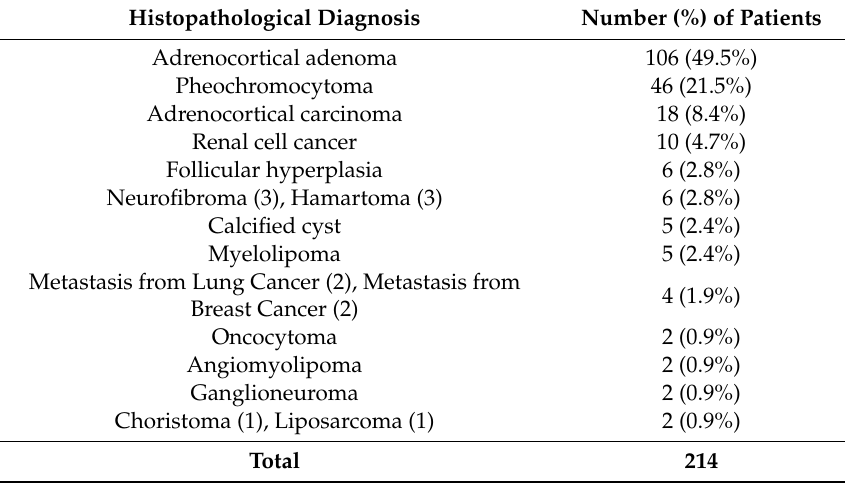
Table 2. Histopathological diagnosis of adrenal incidentalomas following